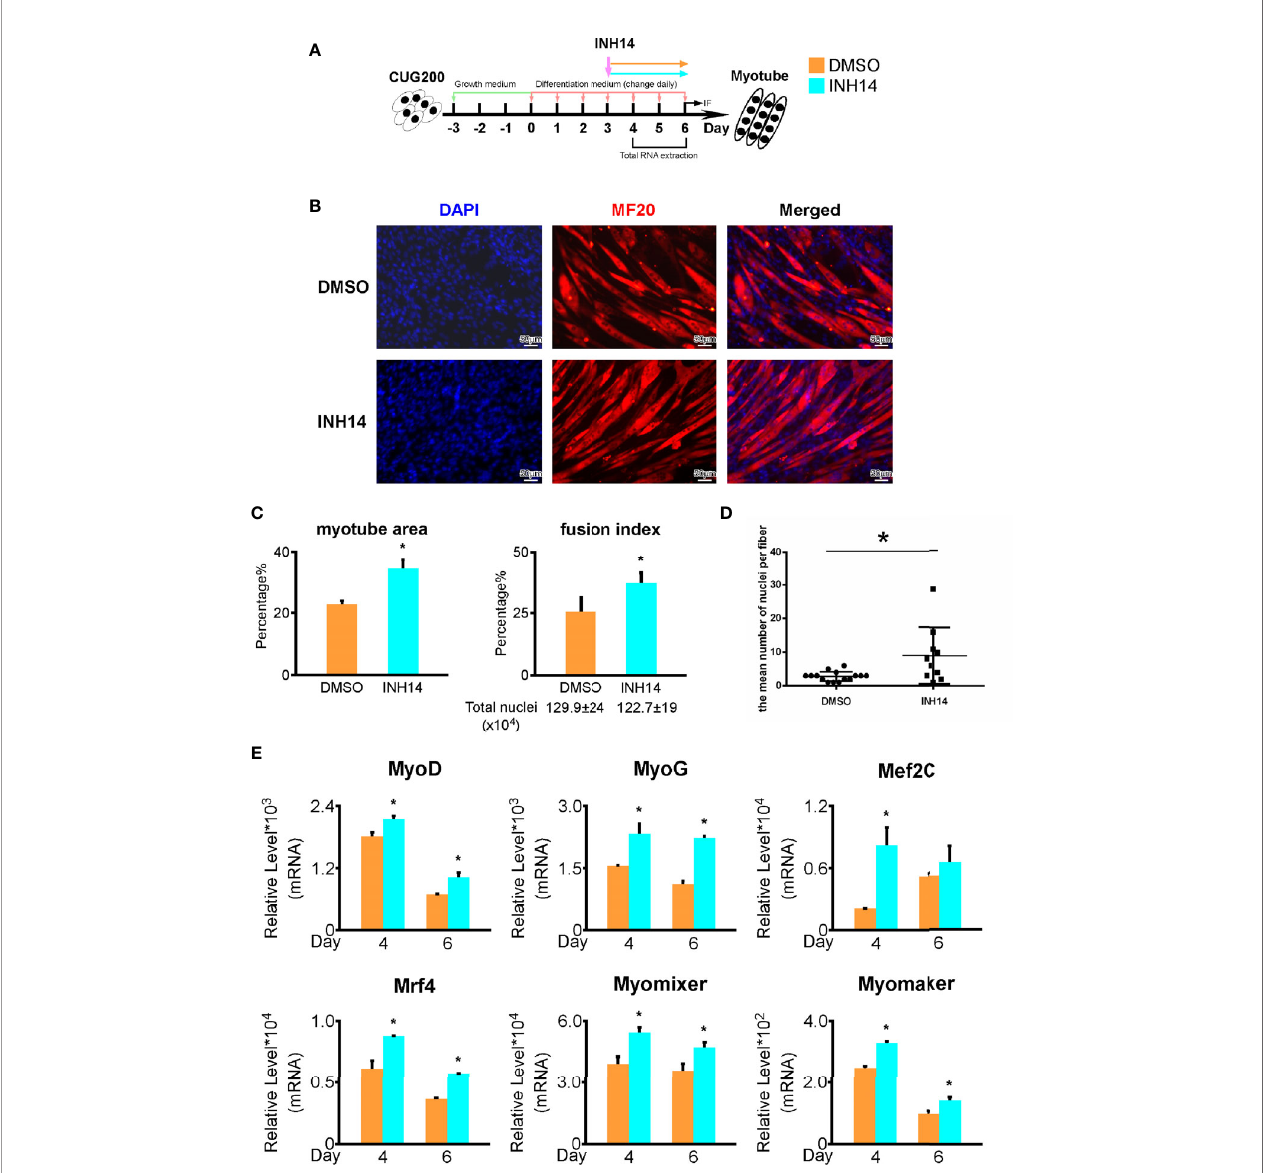
FIGURE 6 | TNF inhibition rescued the DM1 myogenesis defects. (A) 100 nM INH14 (a TNF signaling inhibitor) was added to the DM1 myoblast differentiation to inhibit the TNF signaling from differentiation day 3 to day 6. DMSO was used as a control. (B) The INH14 treatment improved myotube formation in DM1 myoblasts. Immuno fl uorescence staining against MF20 was performed on differentiation day 6. (C) The myotube area and fusion index were signi fi cantly increased with the INH14 treatment. (D) The mean number of nuclei per fi ber was signi fi cantly increased with the INH14 treatment. (E) The expression of muscle regulatory factors (MyoD, MyoG, Mef2C, and Mrf4) and myoblast fusion genes (Myomixer and Myomaker) was signi fi cantly upregulated with the INH14 treatment. DMSO, DMSO treatment control; INH14, INH14 treatment; n ≥ 3; *, p <